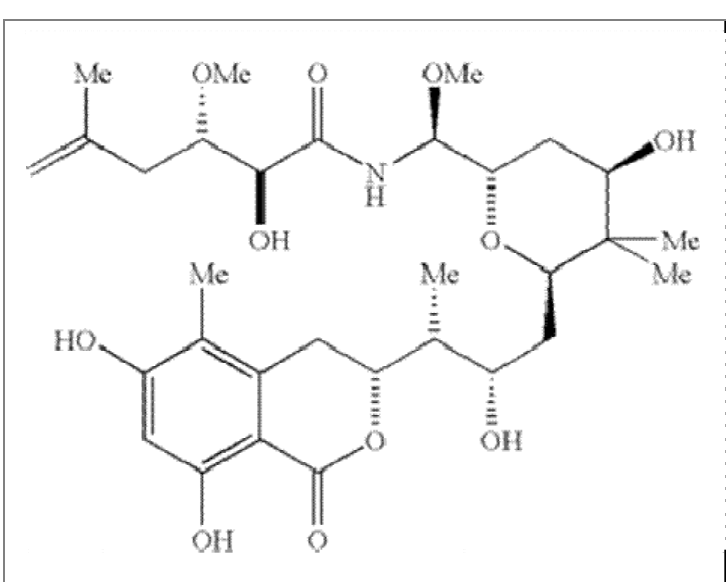
Figure 1. Pederin chemical structure.